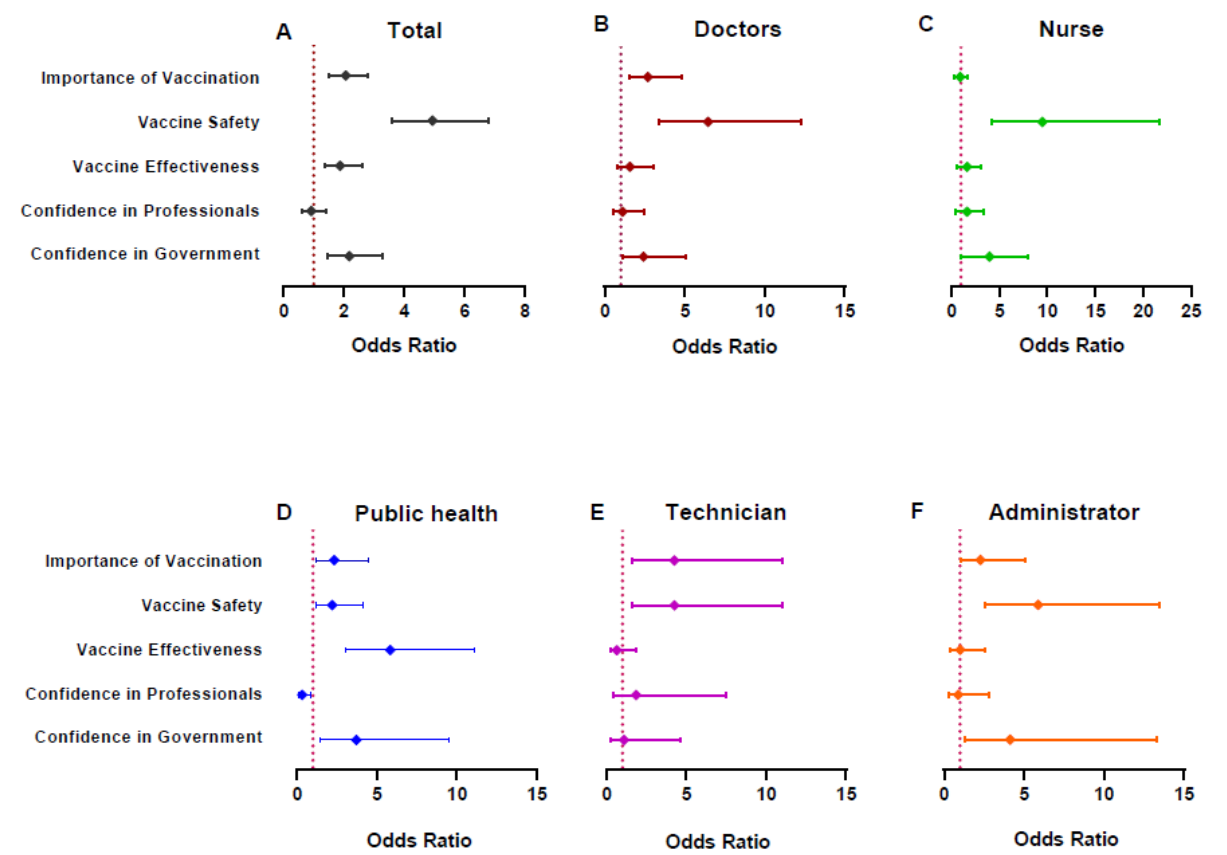
Figure 3. Analysis on the vaccination willingness by vaccine confidence within total sample and each HCWs subgroup basing on logistic regression model. Note: The coefficients of vaccination confidences shown in the graph were adjusted for gender, age group, education and residence. And the coefficients of demographic characteristics were not listed in the figure which could be found in Supplemental Tables S7–S12. For vaccine confidence, the reference groups were set as those reported negative confidence in each of the dimensions. A. Analysis on the vaccination willingness by vaccine confidence within total sample. B. Analysis on the vaccination willingness by vaccine confidence within doctors. C. Analysis on the vaccination willingness by vaccine confidence within nurses. D. Analysis on the vaccination willingness by vaccine confidence within public health employees. E. Analysis on the vaccination willingness by vaccine confidence within technicians. F. Analysis on the vaccination willingness by vaccine confidence within hospital administrators.